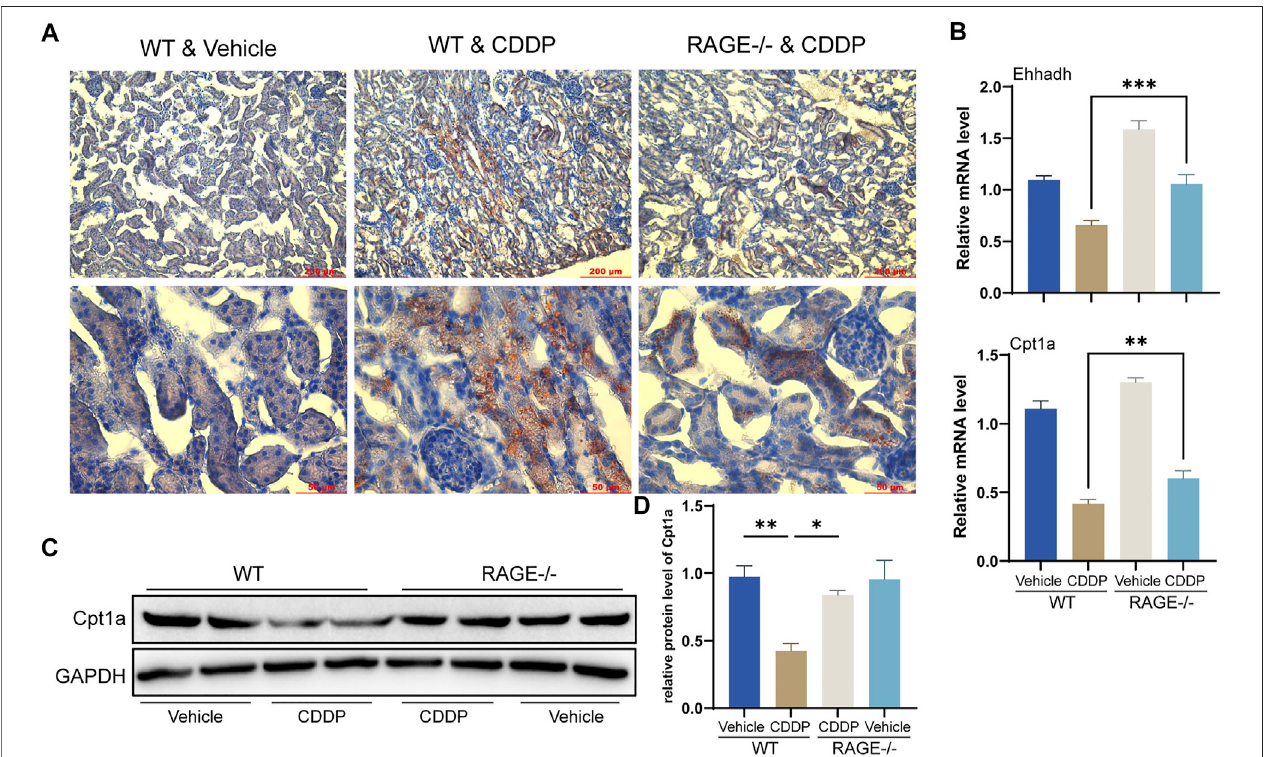
FIGURE 5 | RAGE knockout diminished cisplatin-induced renal lipid accumulation and FAO impairment. (A) Oil Red O staining was performed to assess lipid deposition in the kidney tissues. (B) The histogram indicated mRNA levels of FAO-related genes Ehhadh and Cpt1a. (C) Cpt1a was selected for validation of protein expression with subsequent semi-quanti fi cation (D) . One-way ANOVA was used to compare means between groups. Data are expressed as mean ± SEM. Scale bar: 200 or 50 μ m as indicated in the fi gure. * p < 0.05, ** p < 0.01, *** p <